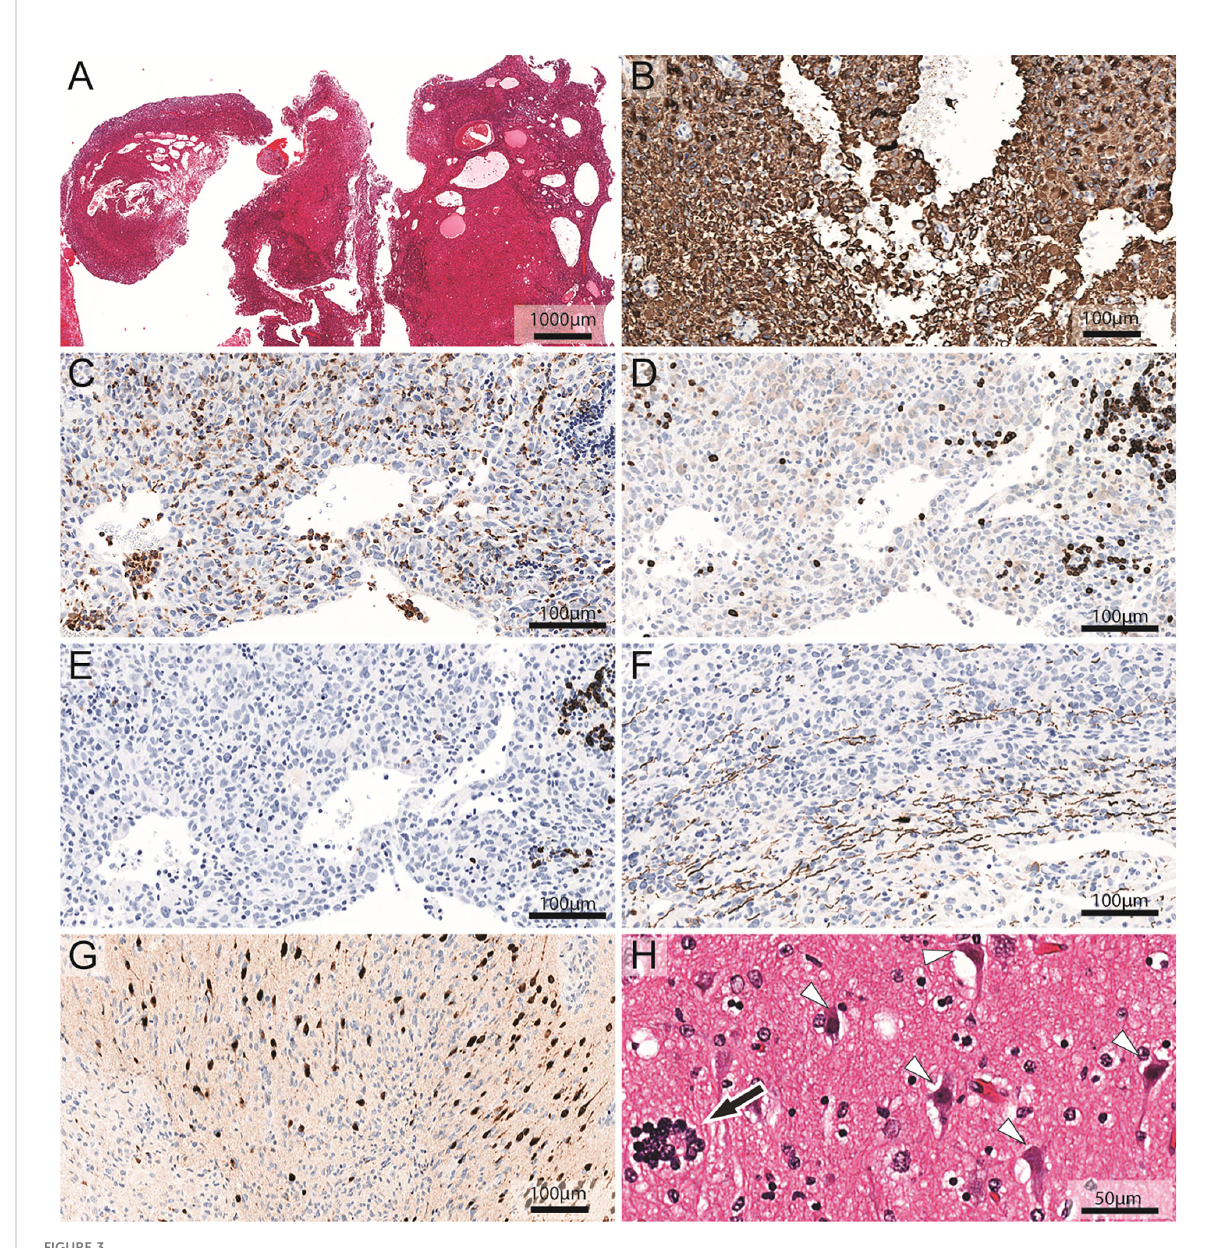
FIGURE 3 Neuropathological analysis of cystic glioblastoma. (A) Hematoxylin and eosin staining of a representative biopsy reveals intratumoral cysts. (B) Glioblastoma cells show strong immunoreactivity (brown color) for GFAP. (C) Anti-CD68 antibodies label macrophages and microglia cells (dark brown cells). The areas of the section without solid tissue represent cyst lumen. (D) Anti-CD3 antibodies label T-lymphocytes (dark brown cells). The areas of the section without solid tissue represent cyst lumen. (E) Anti-CD20 antibodies label immunoreactive B-lymphocytes (dark brown cells). The areas of the section without solid tissue represent cyst lumen. (F) The in fi ltrative growth pattern of the glioblastoma cells in white matter is evident among the axons that are stained dark brown for neuro fi lament heavy chain. (G) Glioblastoma cells in fi ltrate neocortical tissue where neurons are stained dark brown for NeuN. (H) Hematoxylin and eosin staining of neocortex shows damaged neurons (white arrowheads) with shrunken, triangular appearance and condensed chromatin. Prominent satellitosis (56) can be seen (black arrow). Please note the proximity of tumor-associated leukocytes to the cyst lumen (C – E) . Note also how macrophages and lymphocytes may both be scattered throughout the tumor and appear in groups (C – E) and how neurons (brown nuclei) embedded among tumor cells (blue nuclei) appear pycnotic in the center of (G)